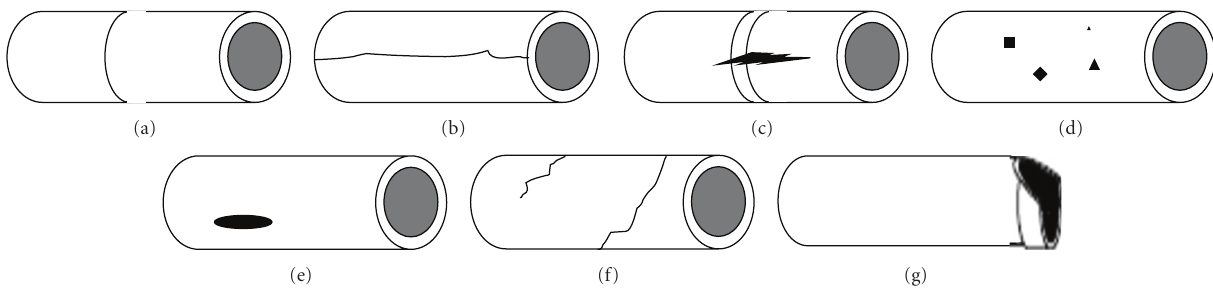
Figure 2: Di ff erent types of pipe breaks. Adapted from [6]. (a) Circumferential cracking; (b) Longitudinal cracking; (c) Bell splitting; (d) Corrosion pitting; (e) Blow-out hole; (f) Spiral cracking; (g) Bell